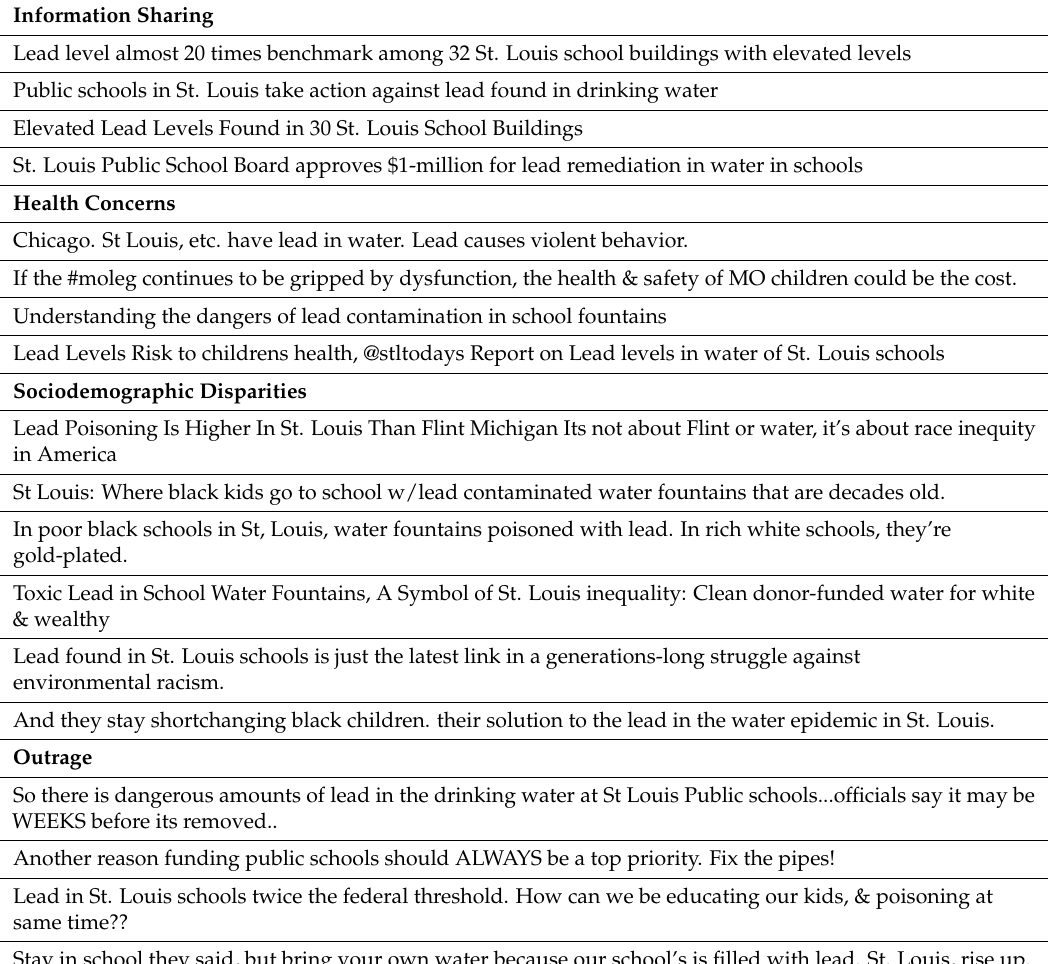
Table 2. Example tweets by theme.